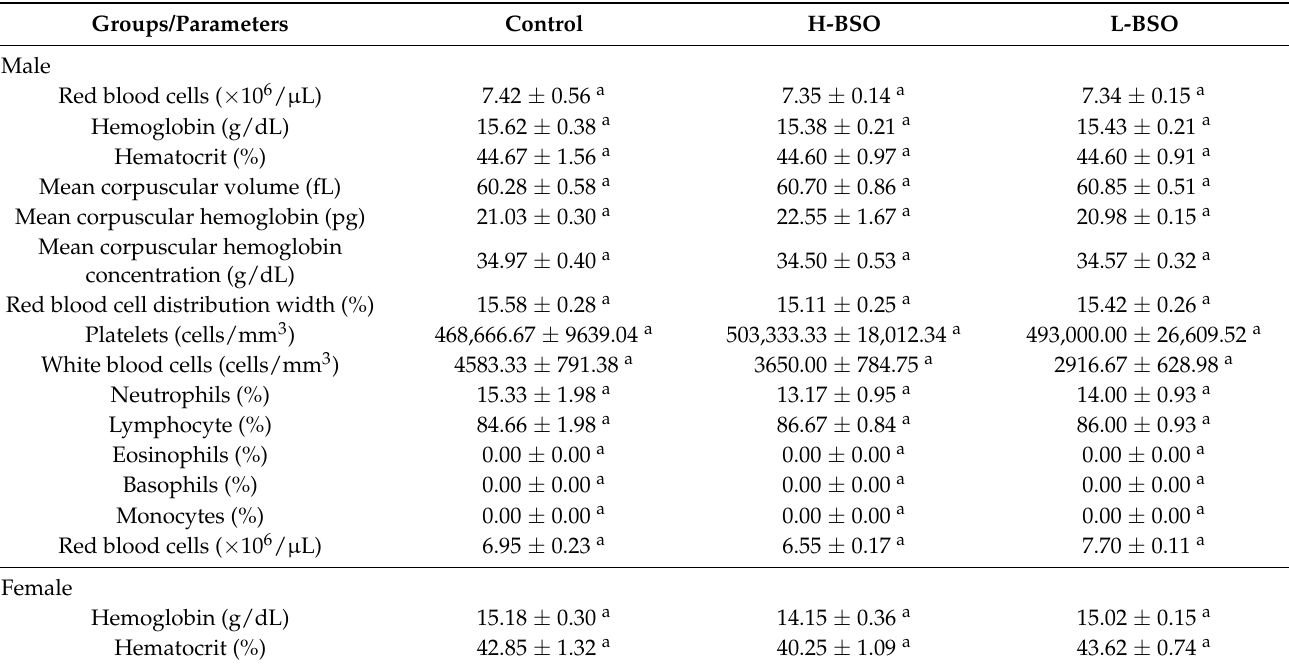
Table 5. Hematological parameters of male and female rats treated with BSO for 28